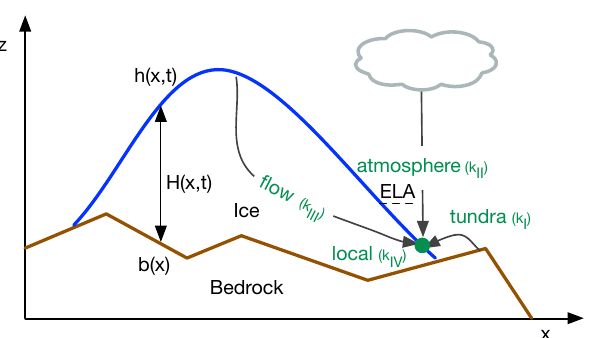
Figure 1. Cross section through an ice sheet: the different mech- anisms of aerosol transport to the ablation zone. ELA stands for equilibrium line altitude, b is the (fixed) bedrock elevation, h the ice surface elevation and H the ice thickness.